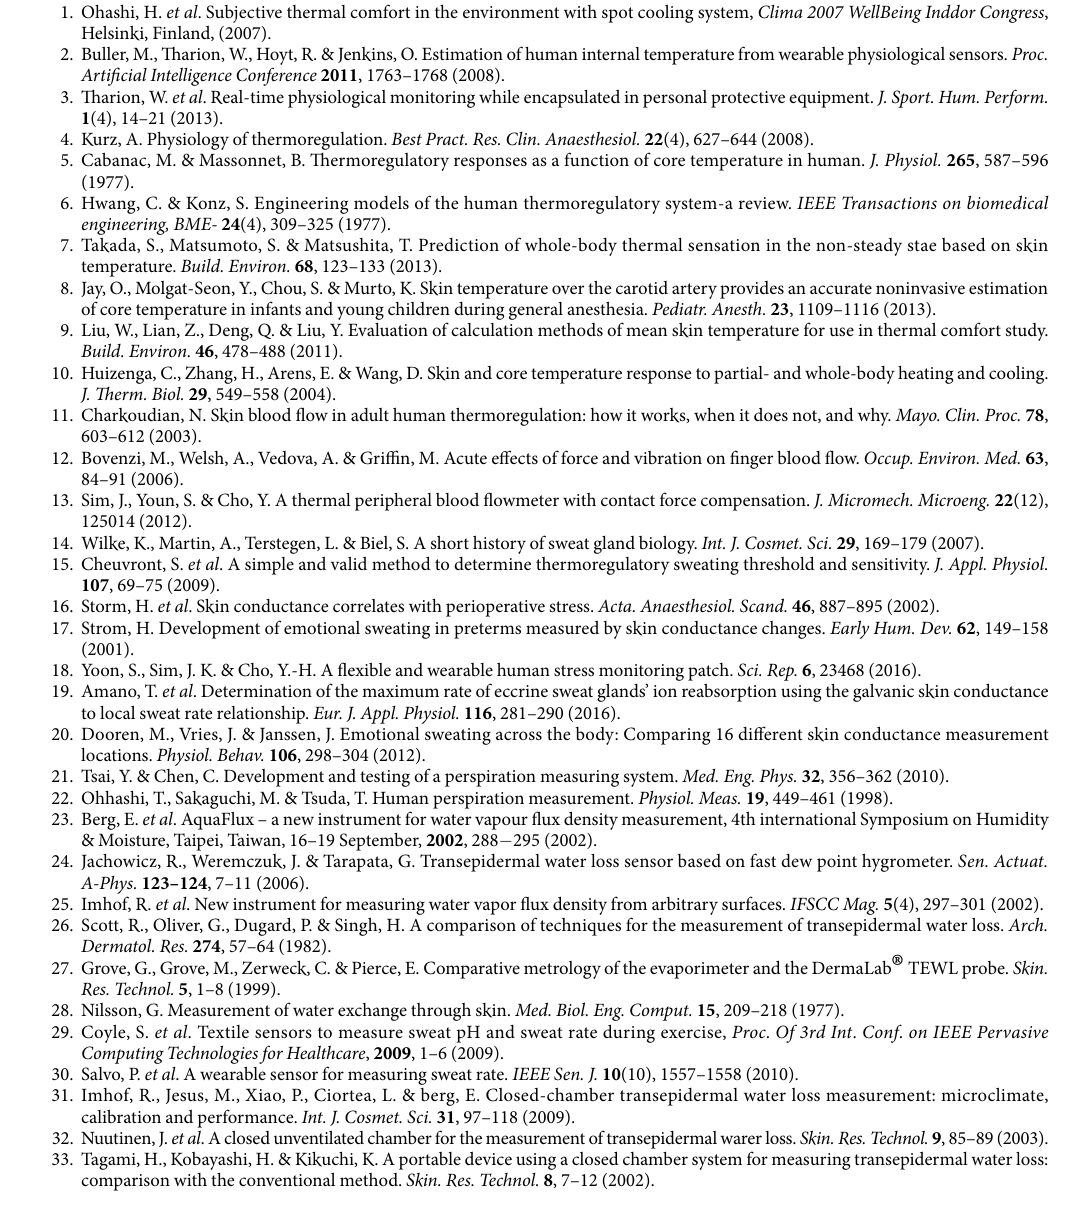
where, SR is the sweat rate, W is the weight of water loss, A is the area of petri dish, and T is the time. This cal- culated sweat rate value is used for the sweat rate calibration when the sensor is placed on the semipermeable membrane. The artificial skin (wet-cup method) offers a reference to characterize the performance of the sweat rate sensor. Human